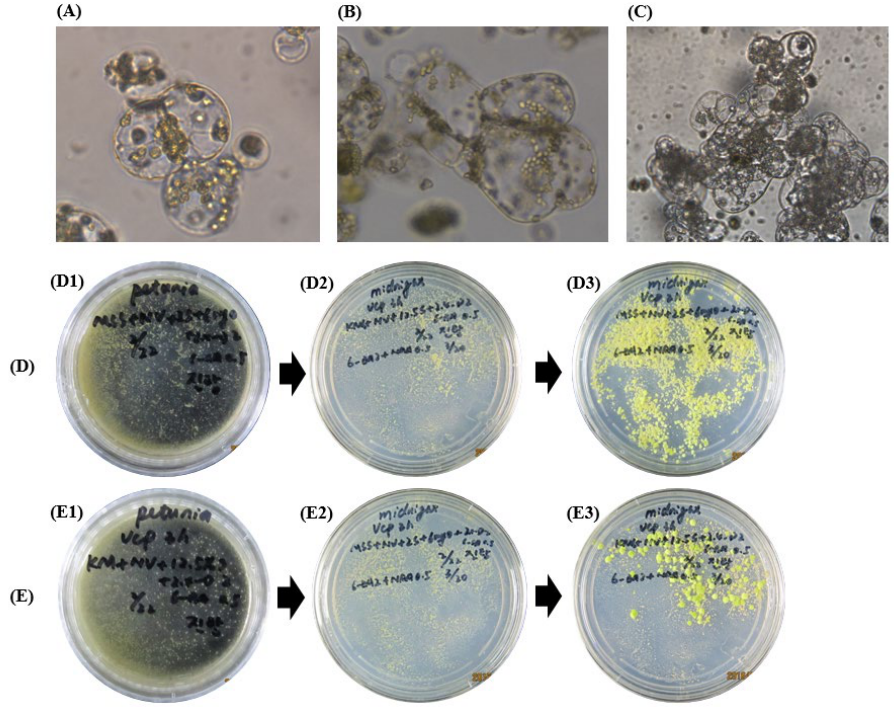
Figure 2. Protoplast-derived cell division for colony formation and proliferation in two callus in- duction media. A to C: Isolated protoplasts showing initiation of cell division on colony induction medium for 1 ( A ), 3 ( B ), and 7 ( C ) days after culture. The colonies were moved to callus induction media ( D and E , respectively) as indicated. Medium D was composed of MS salt, 6% myo-inositol, 2% sucrose, 2 mg/L 2,4-D, and 0.5 mg/L 6-BAP. Medium E was composed of Kao and Michayluk (KM) salt, NLN vitamin, 12.5% sucrose, 2 mg/L 2,4-D, and 0.5 mg/L 6-BAP. The pictures in ( D1 , E1 ) were taken 4 weeks after colony formation. The pictures in ( D2 , E2 ) show the colony growing to form callus after transferring to callus induction media. The pictures ( D3 , E3 ) were taken 3 weeks after callus formation.